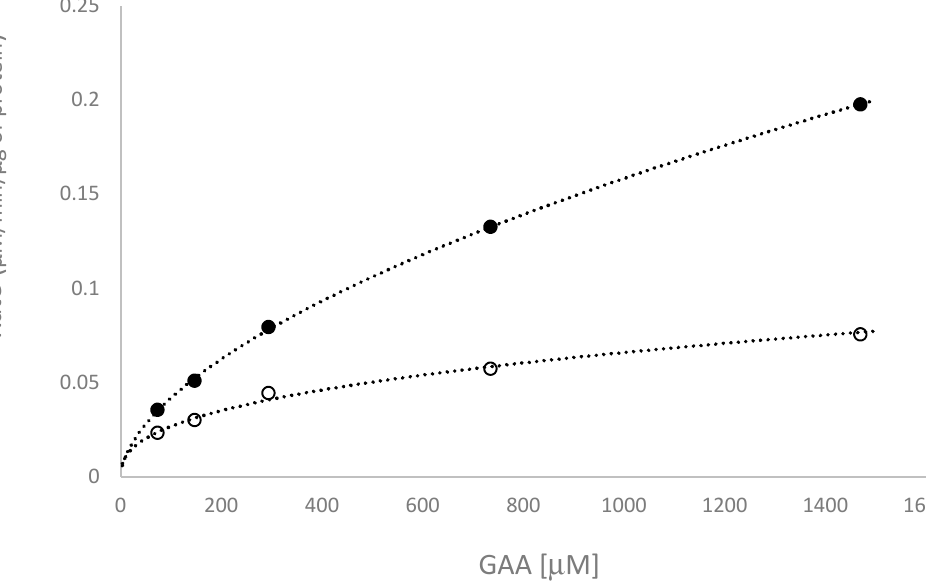
Figure 5. Kinetic study of BsGT110 at pH 6 (closed symbols) and pH 7 (open symbols). Different concentrations of GAA were mixed with 15 µ g purified BsGT110 protein, 10 mM UDP-glucose, 10 mM MgCl 2 , and 50 mM PB (pH 7.0) or acetate bu ff er (pH 6) in 1 mL reaction mixture and incubated at 40 ◦